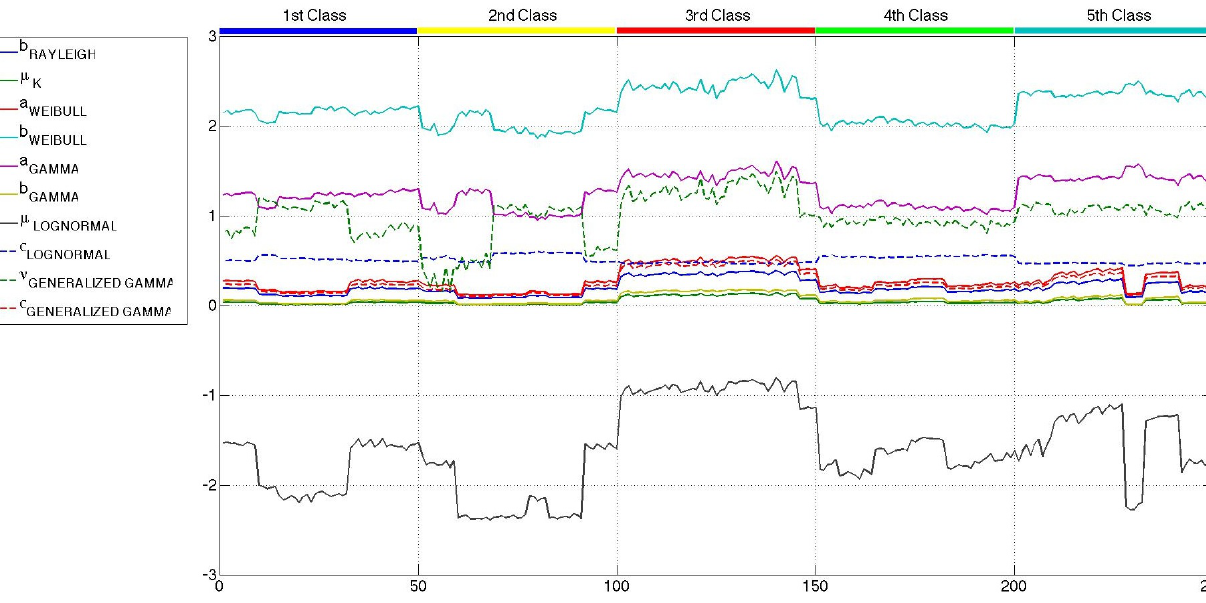
Figure 10. Selection of statistical parameters estimated from a reduced set of original patches. Fifty patches of each considered class are used for the